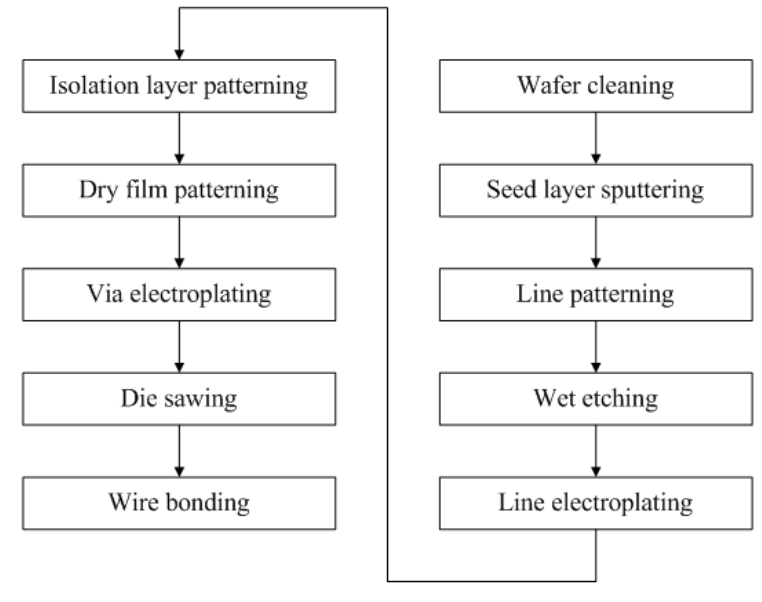
Figure 7. The fabrication process of the MEMS transformer.